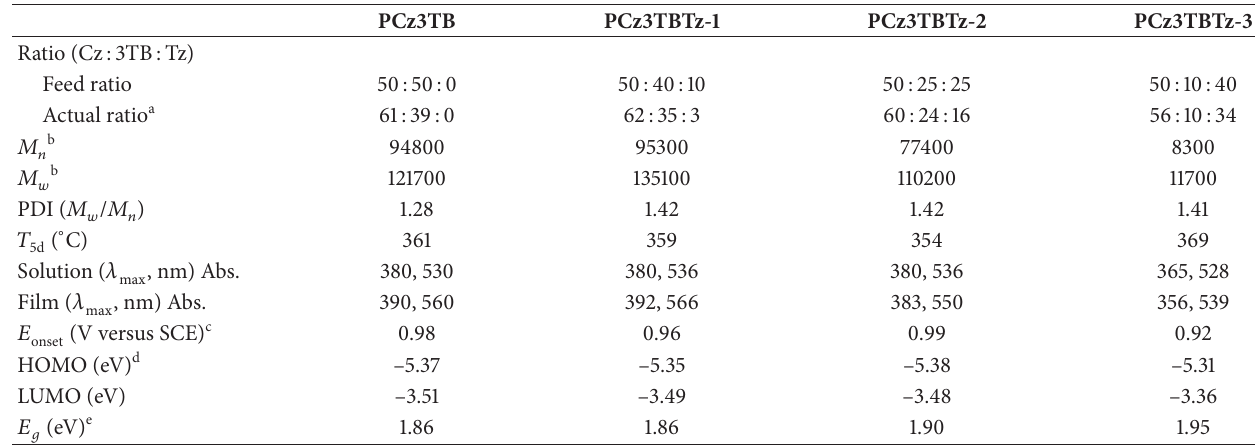
Table 1: Physical properties of